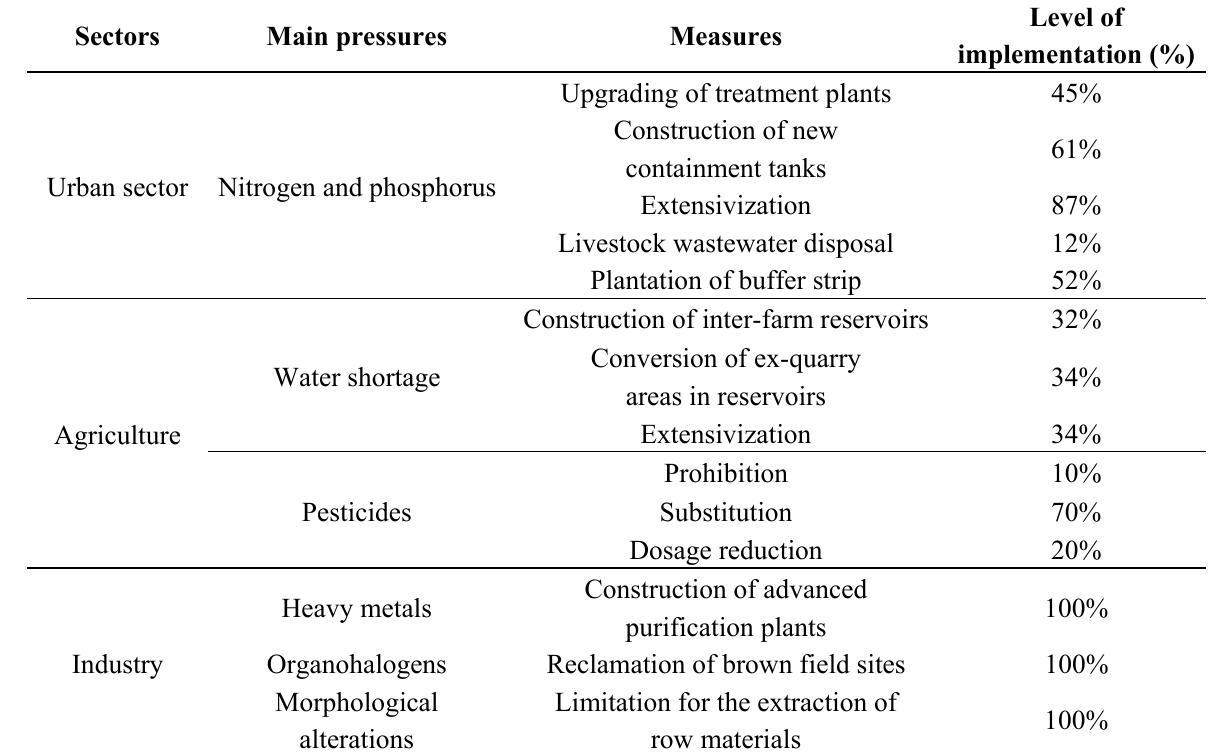
Table 4. Level of implementation of each measure for each type of pollutant and for each source of